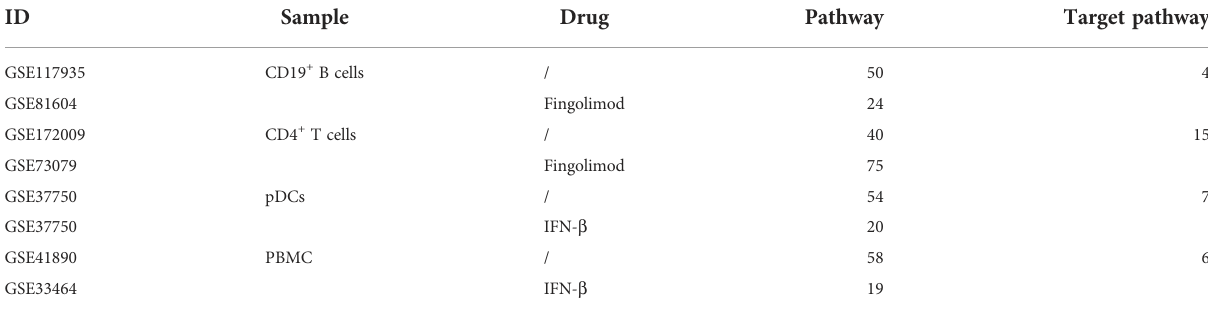
TABLE 4 The number of enriched pathways of DEGs in MS patients without treatment, the number of enriched pathways of DEGs before and after application of Fingolimod or IFN- b , and the number of target pathways.